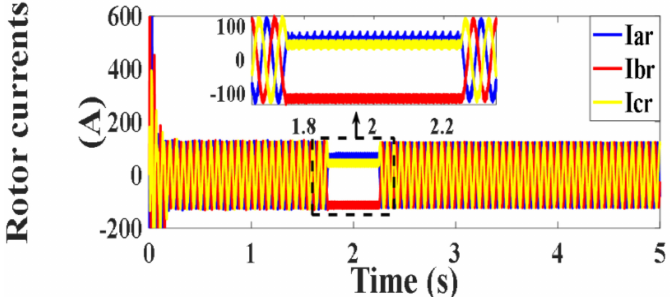
Figure 29. Rotor currents under MPCC (A).